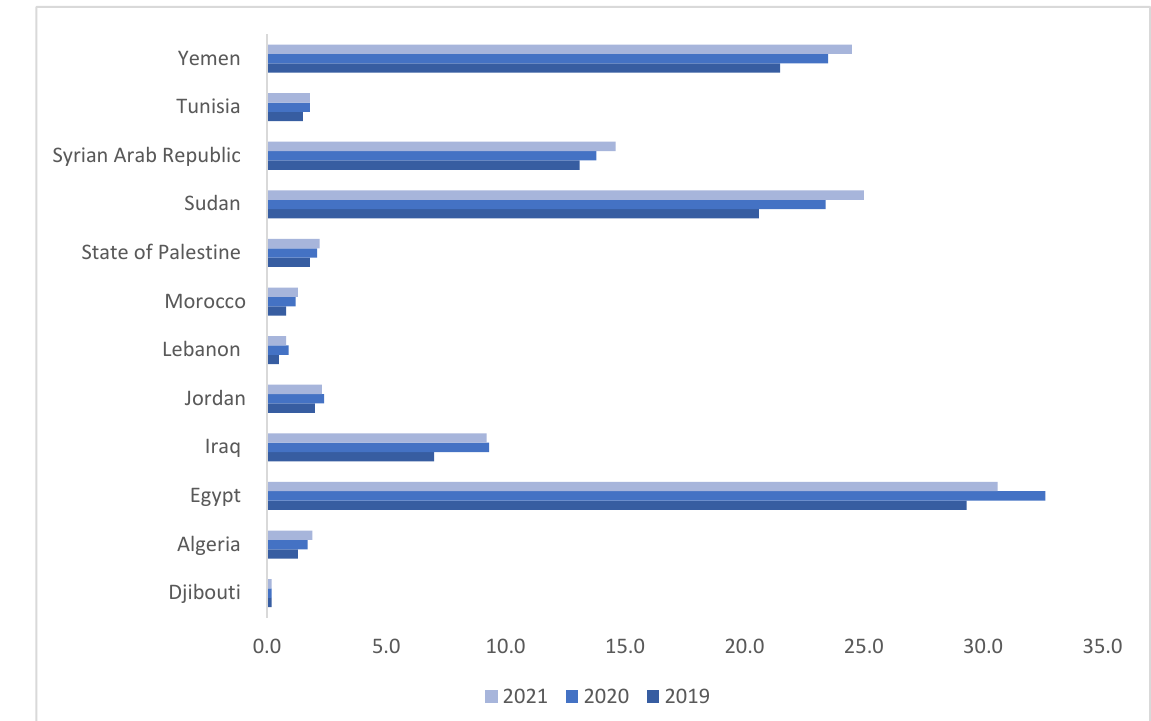
Figure 1. Headcount poverty ratios (%) using national poverty lines. Source: (UN-ESCWA 2020). Note: The results are the output of the projected scenario; for more details about the results of other scenarios, please see UN-ESCWA (2020).